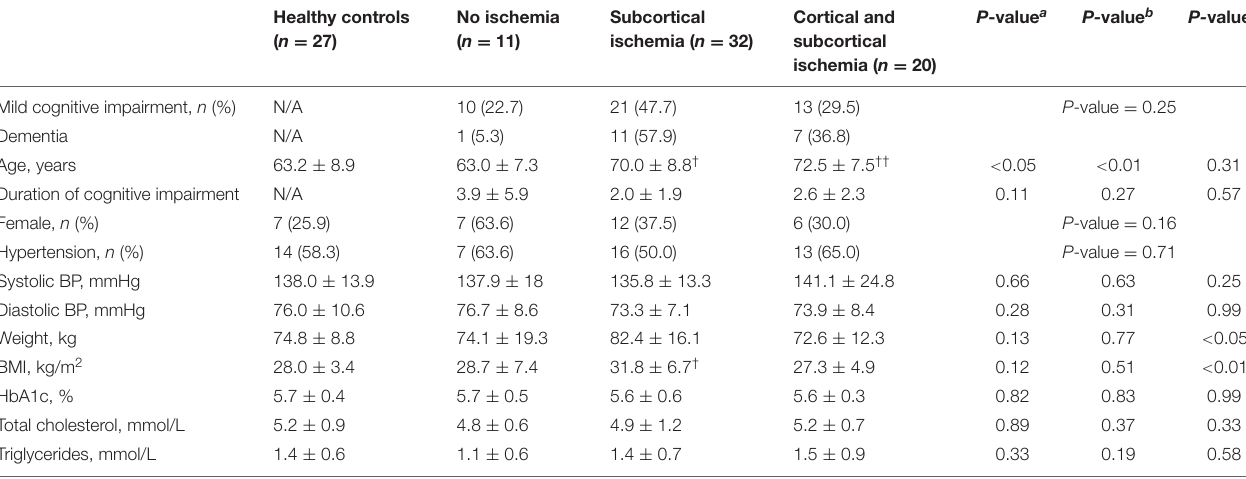
TABLE 1 | Comparison of demographic and clinical characteristics between healthy controls and no ischemia, subcortical ischemia and both cortical and subcortical ischemia in subjects with MCI and dementia.